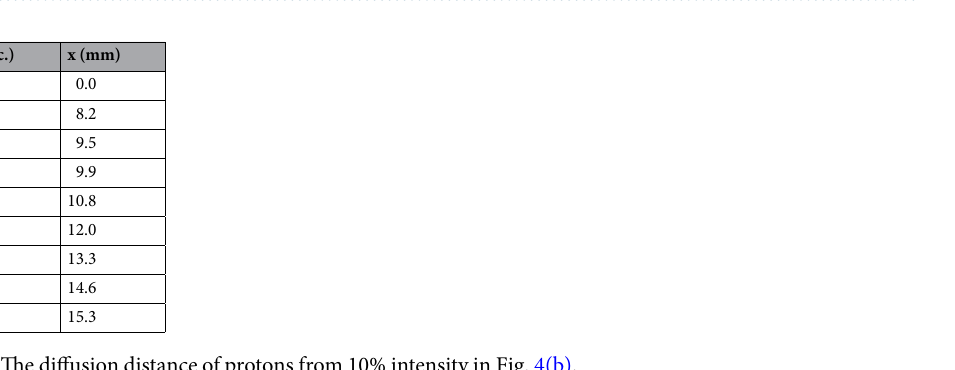
x: Diffusion distance, D: diffusion coefficient, t: time From the inset in Fig. 5, D = 1.39 × 10 − 3 (mm 2 /s) was obtained as the value of the diffusion coefficient D , using the slope ( 2D ) of the fitting line. The black line in Fig. 5 is a curve drawn using the resultant value. Although there is some deviation, it almost follows Eq. (5). Additionally, according to the literature, the diffusion coefficients of protons in water and gel are close to D water = 8.24 × 10 –3 (mm 2 /s), obtained by scaling the water interatomic poten- tial model 22 , and D gel = 6.22 × 10 –3 (mm 2 /s), obtained from PFGSE-NMR spectroscopy 23 , respectively. Although the measured values in the present study yield slightly lower values than the above, the diffusion coefficient of protons can be estimated using the BTB agar gel method. Simulation for AiS reaction by colour patterning.